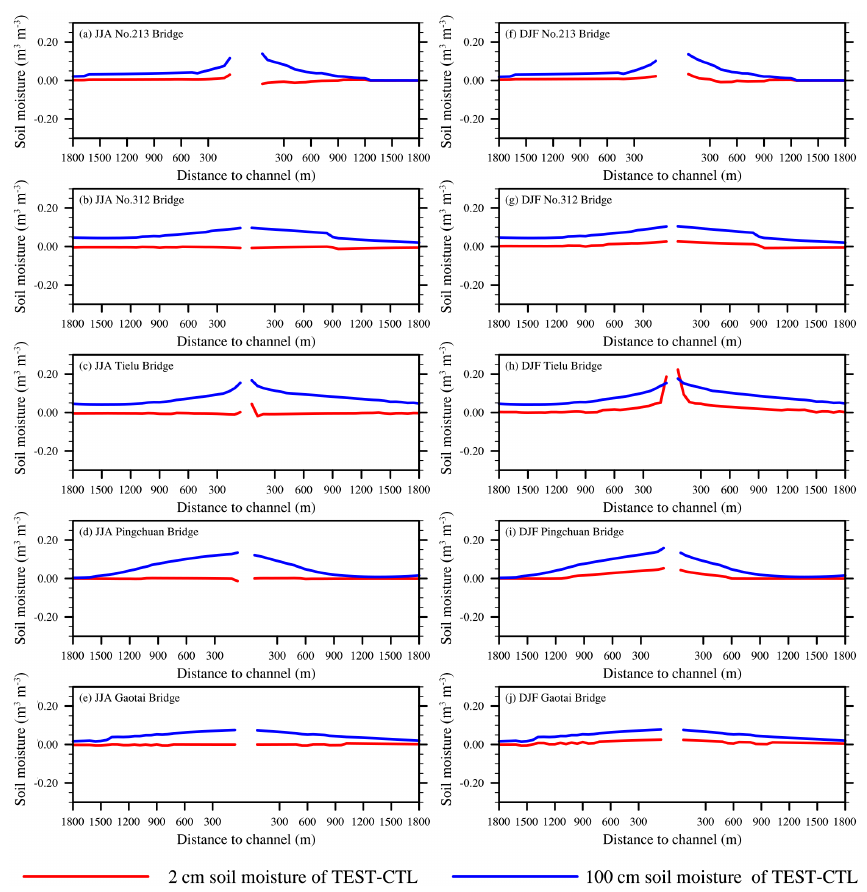
Figure 14. Differences of (a–e) summer and (f–j) winter soil moisture (both liquid water and ice are included) predicted at depths of 2 and 100cm by TEST and CTL simulations along the five sections at (a, f) 213 Bridge, (b, g) 312 Bridge, (c, h) Tielu Bridge, (d, i) Pingchuan Bridge, and (e, j) Gaotai Bridge. The discontinuous parts of the curves represent the river areas.